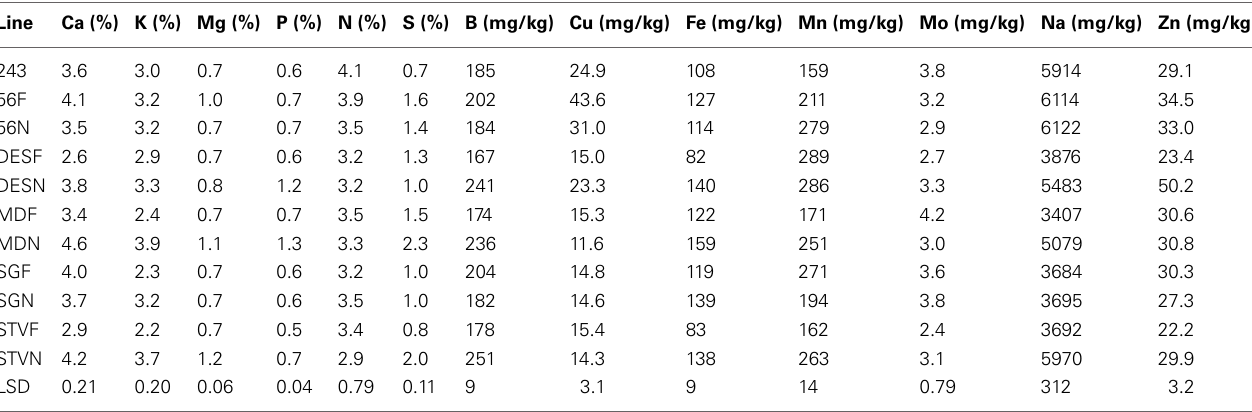
Table 6 | Characterization of leaf nutrients composition as influenced by fuzz (F) and fuzzless (N) seed trait in cotton isogenic mutant lines under well watered conditions ∗ .